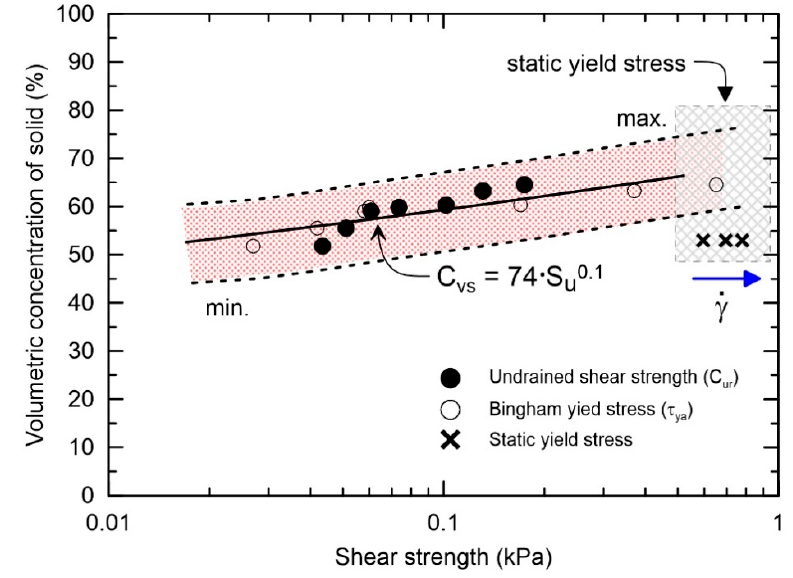
Figure 6. Relationship between the shear strength and the solid volume concentration.